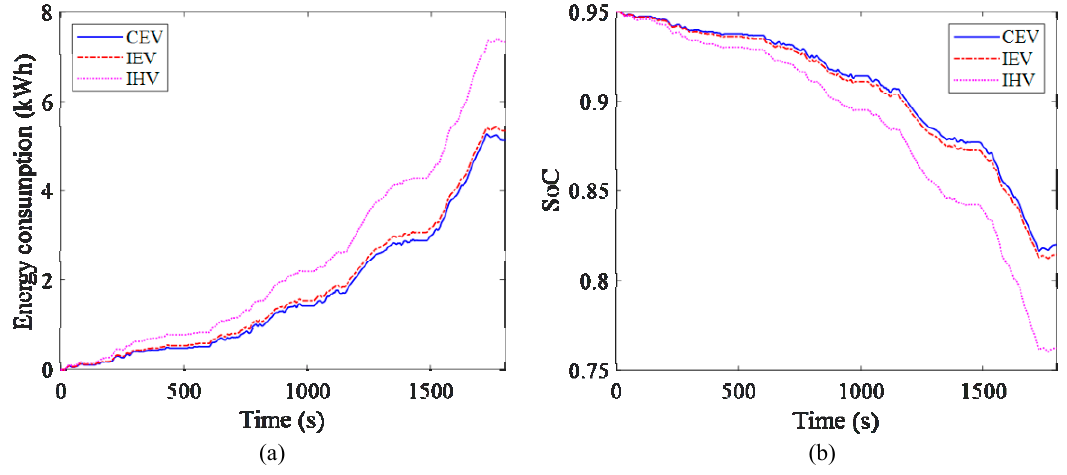
Figure 10. Energy consumption and SoC of each vehicle. Table 4. Energy consumption and SoC comparison.